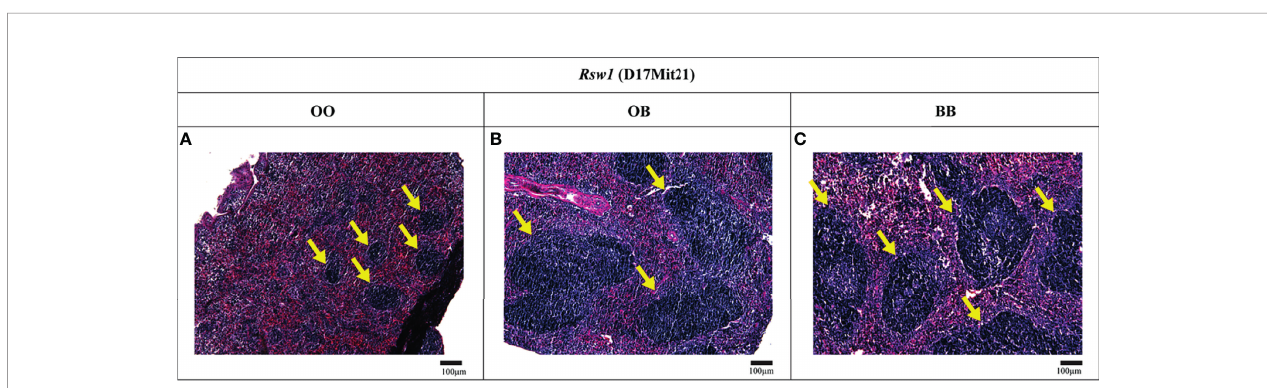
FIGURE 7 | Spleen histology. Light micrographs of the hematoxylin and eosin-stained paraf fi n-embedded spleen sections of F 2 hybrids between B10.O20 and B10. Indicated alleles in bold correspond to the genotype of Rsw1 (linked with D17Mit21). White pulps regions are indicated by yellow arrows. Bars represent 100 m m. Original magni fi cation